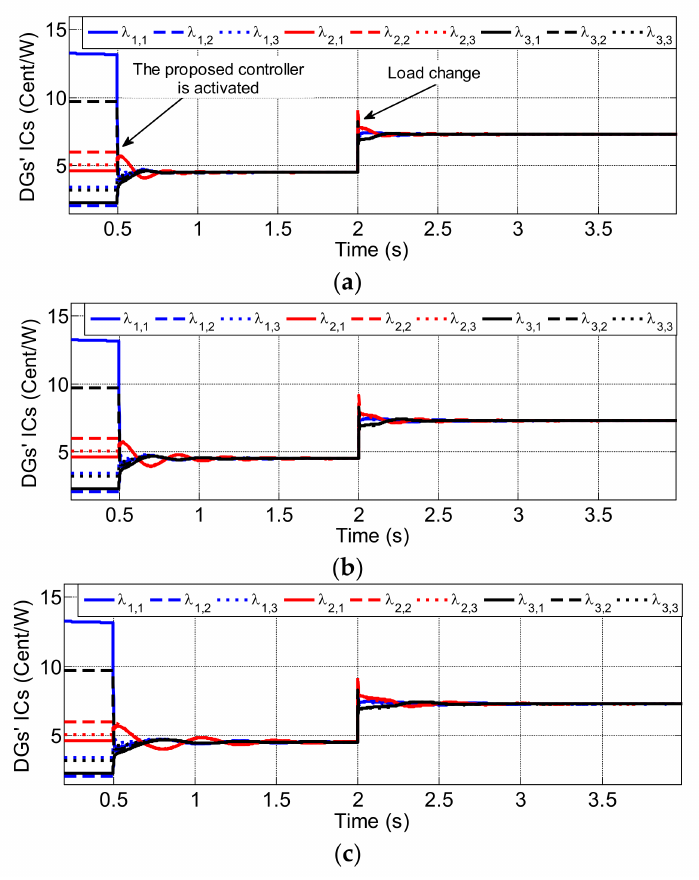
Figure 9. The developed control system with cyber delays: ( a ) with 50 ms delay, ( b ) 100 ms delay, and ( c ) 200 ms delay.